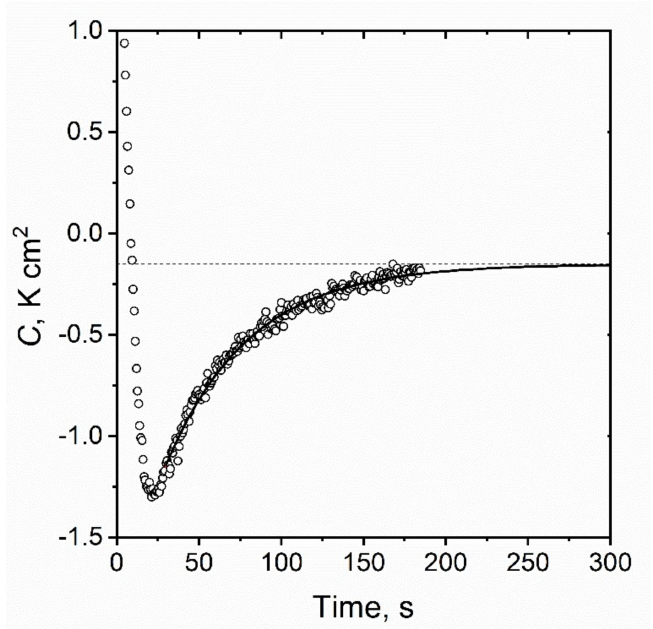
Figure 1. Evolution of coefficient C with time in an experiment with a flame at φ = 0.7 and V g = 16.0 cm/s: Symbols represent experiments. Solid line is an exponential fit to the data, starting at t = 30 s, and extrapolated beyond the experimental time. Dashed line at C = − 0.1509 K cm 2 is the value that the C coefficient approach according to the fitted